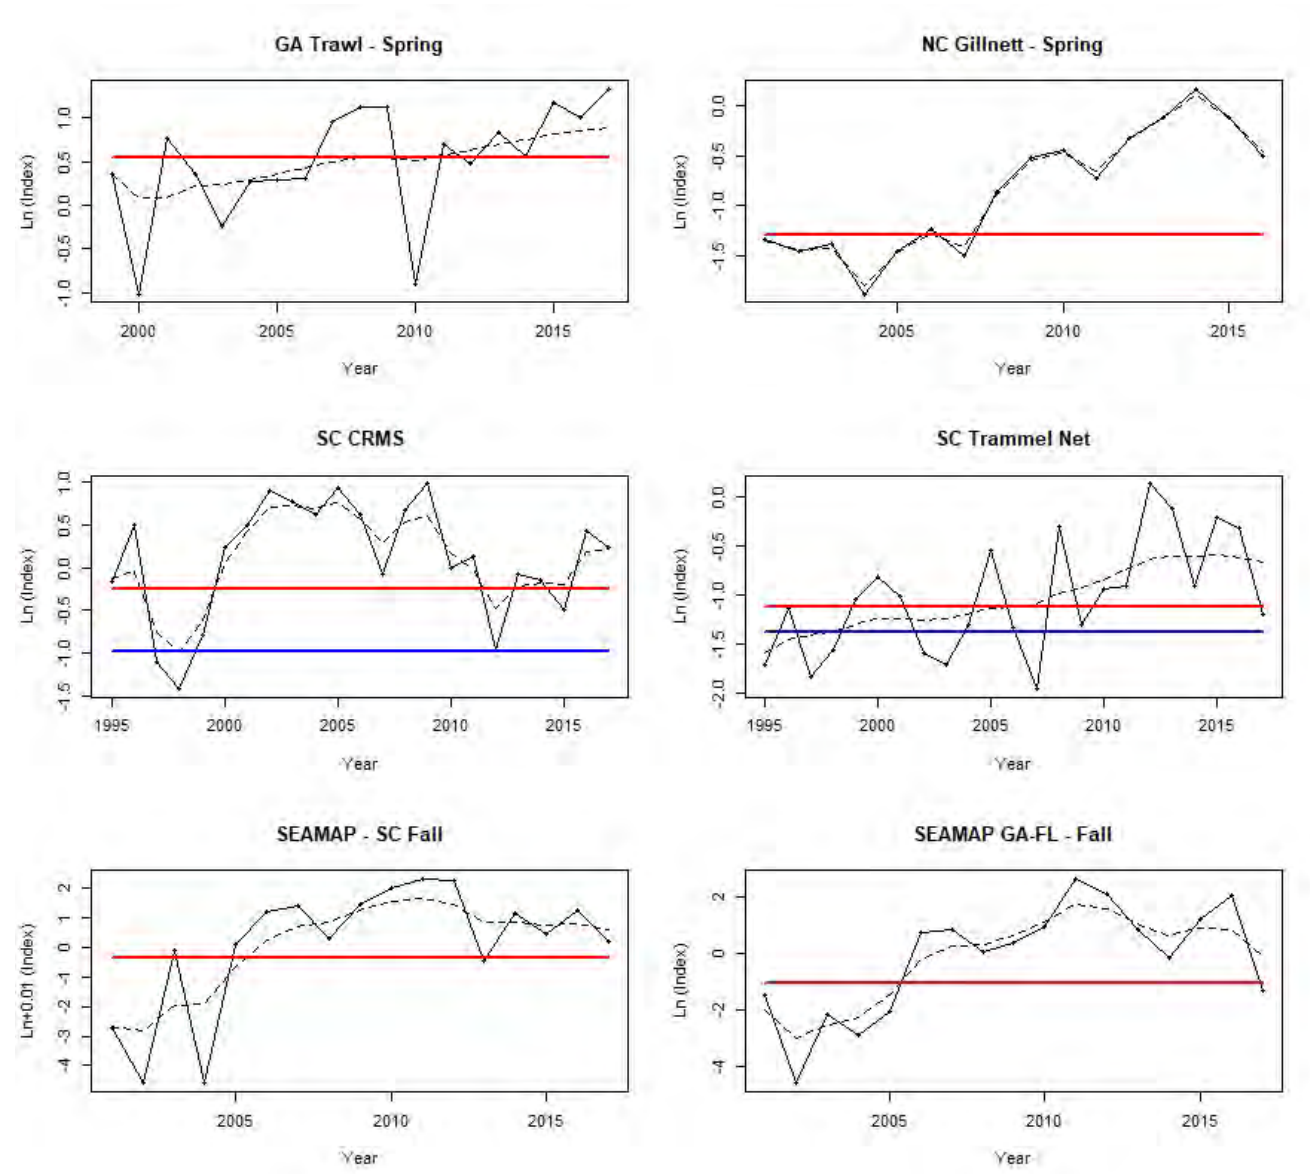
Figure 89. Southeast Region horseshoe crab survey ARIMA model fits. The solid line represents the observed ln transformed indices and the dashed line represents the fitted indices. The red horizontal line represents the Q 25 reference point and the blue horizontal line represents the 1998 reference point. Note: The residuals from the ARIMA fit to the GA Trawl were not normally